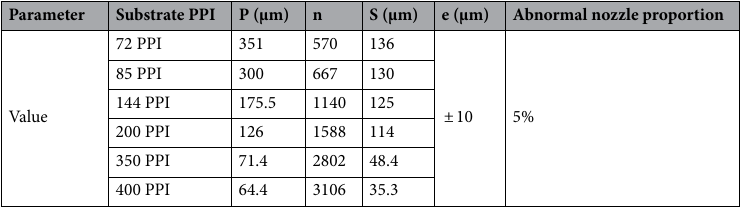
Table 2. Default calculated parameters for printing planning.